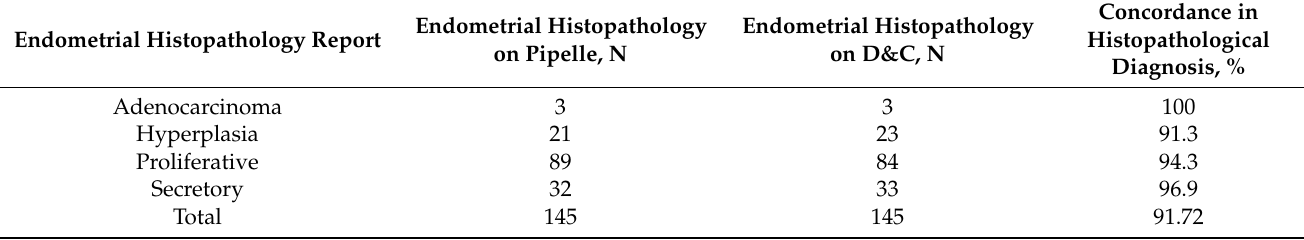
Endometrial Histopathology